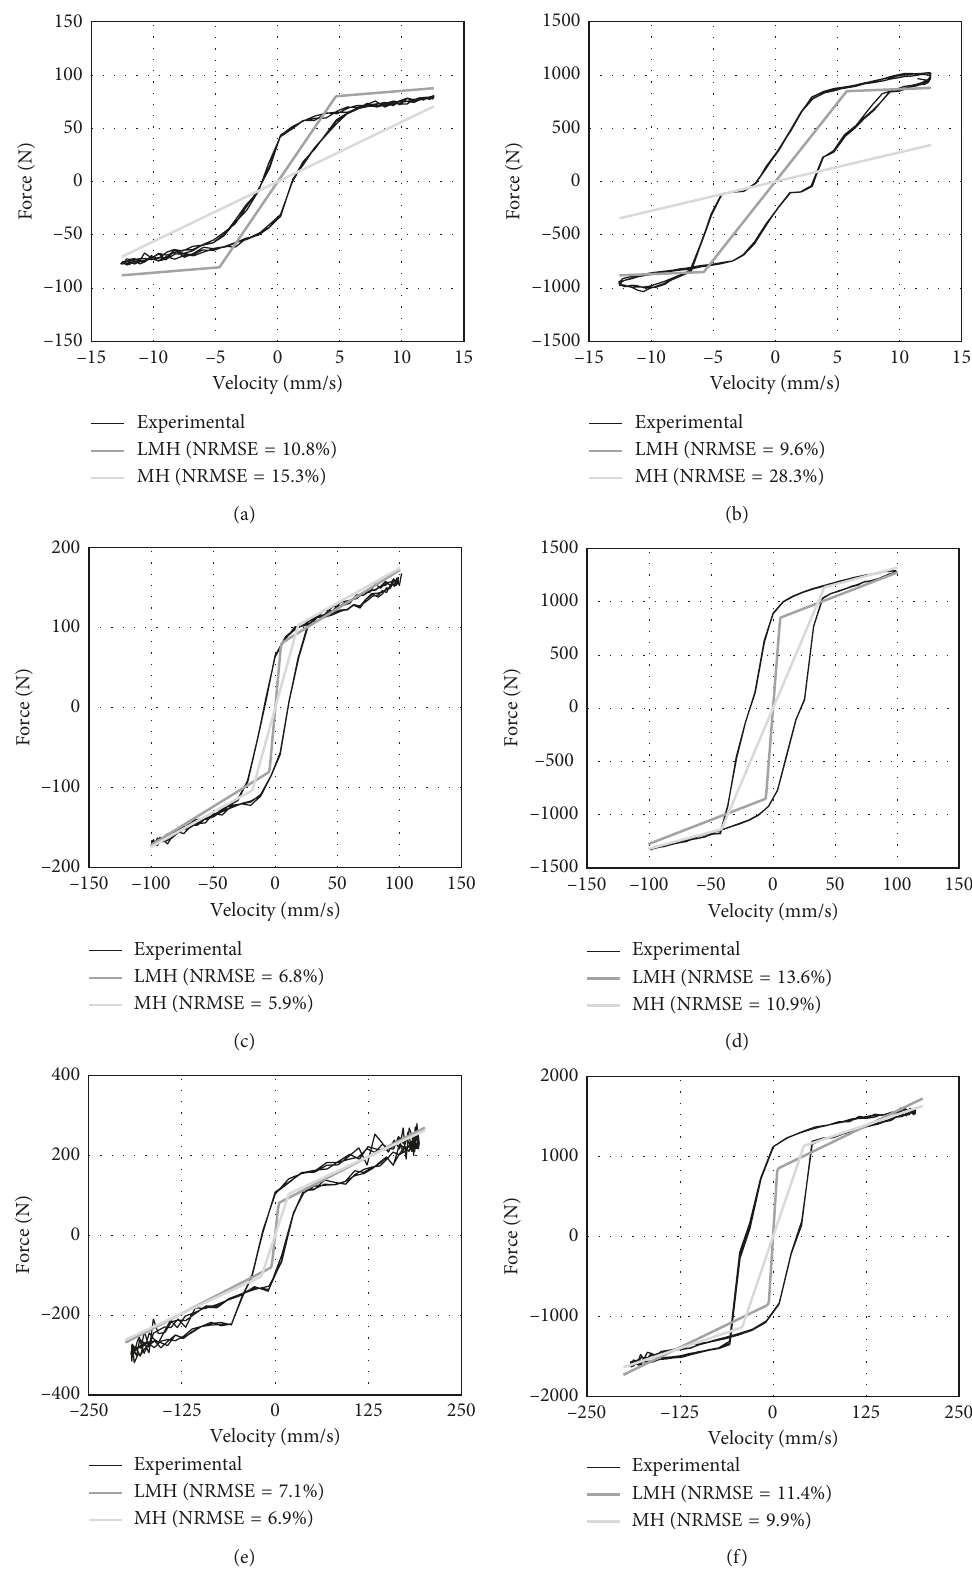
Figure 9: Biviscous model (fitted with LMH and MH tests) predictions for six different tests: (a) low velocity without intensity; (b) low velocity with I 1 A; (c) medium velocity without intensity; (d) medium velocity with I (cid:31) velocity with I (cid:31)